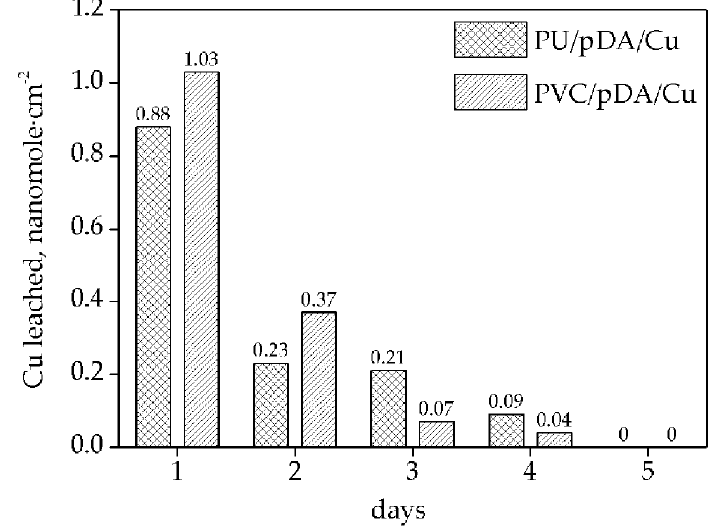
Figure 4. ICP-MS data of copper leached from the surface of Cu-modified polymers during 5 days.